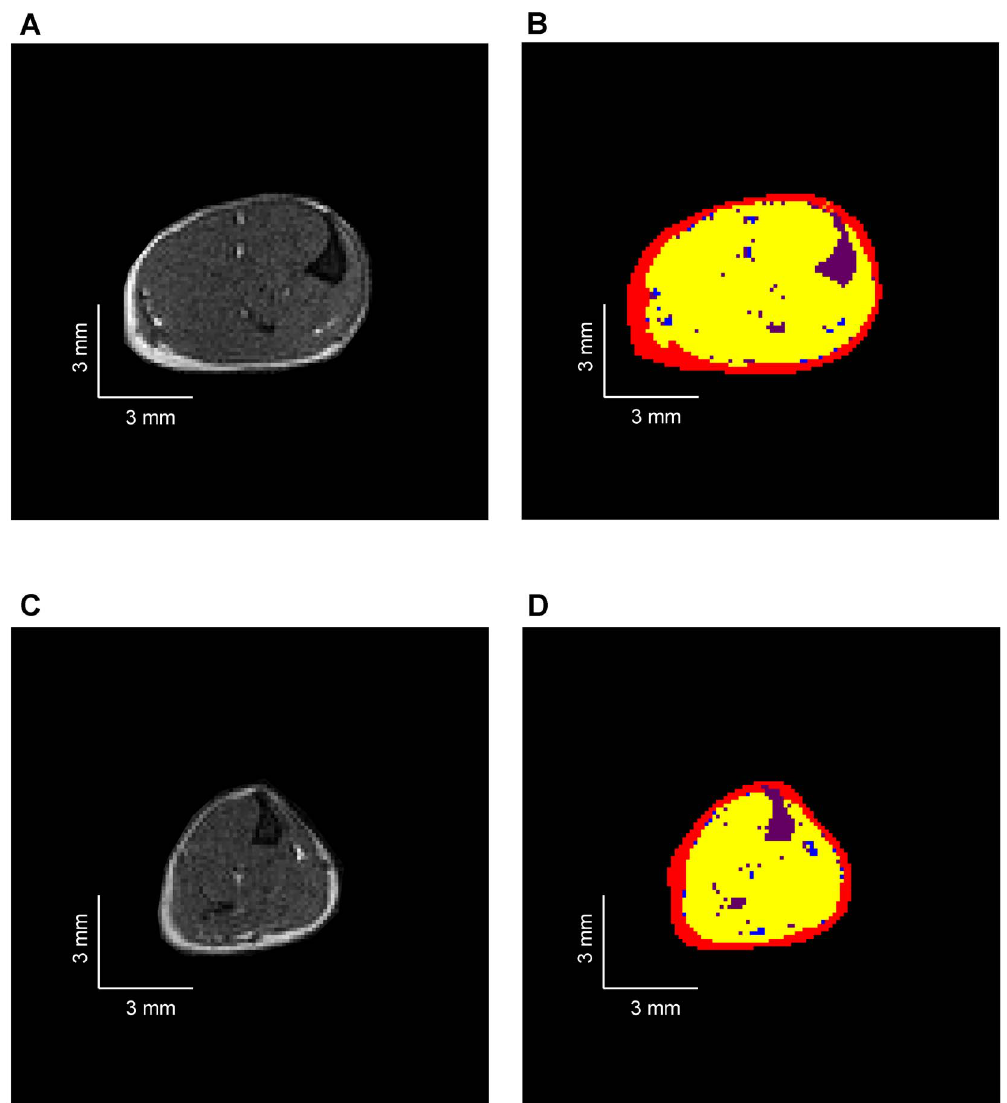
Figure 1. Typical representative axial MR images obtained from WT (A) and H40Y (C) hindlimb muscles and the corresponding automatic segmentation allowing the separation of subcutaneous fat (red), intermuscular fat (blue), skeletal muscle (yellow) and bone/vessels/connective tissues (purple) for WT (B) and H40Y (D) hindlimb. H40Y group showed large muscle atrophy as compared to WT